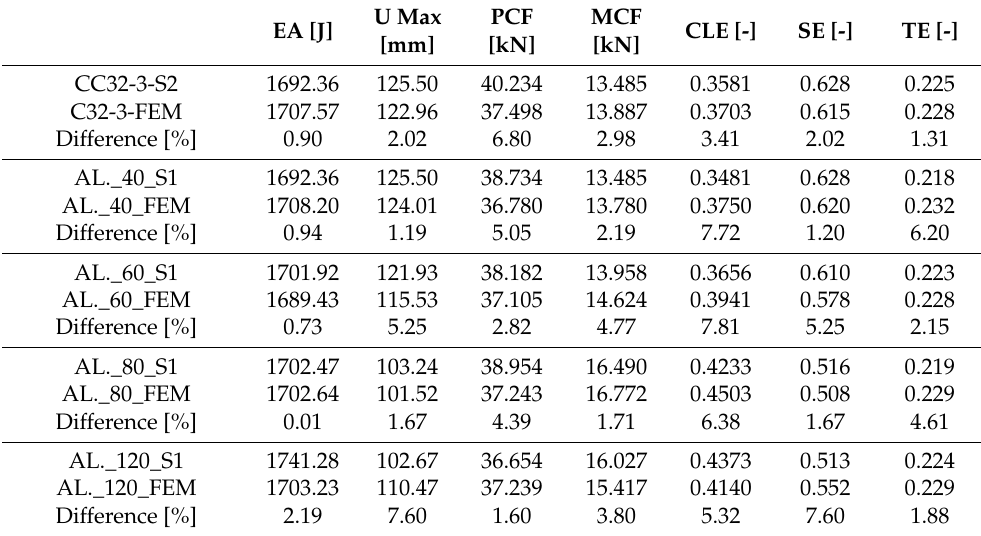
Table 4. Difference between numerical and experimental energy absorption